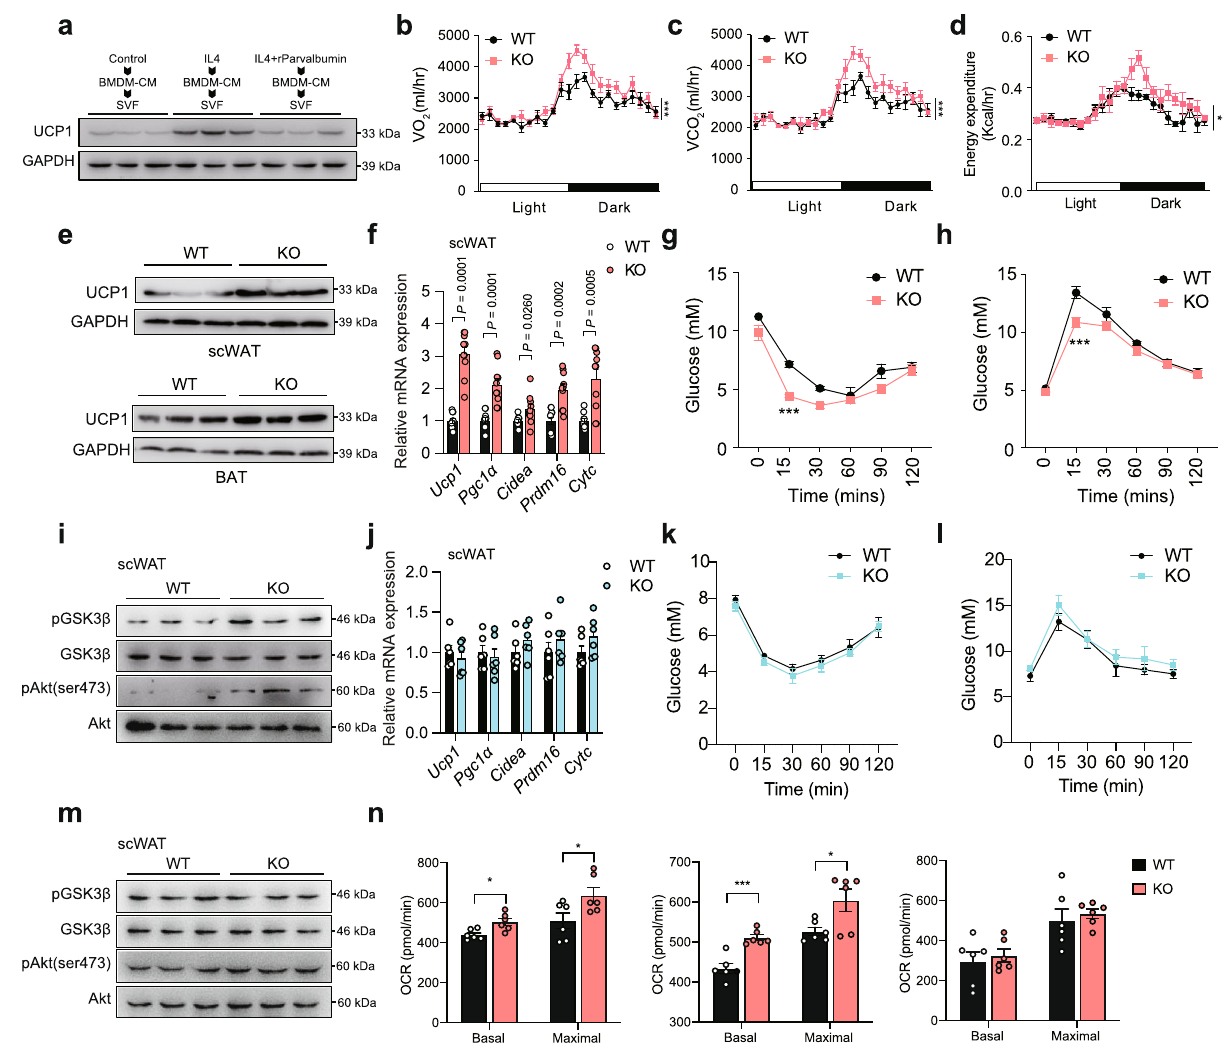
Fig. 5 Effects of parvalbumin KO on thermogenesis, insulin sensitivity, and glucose homeostasis. a Immunoblots of UCP1 in primary adipocytes after exposure to CM for 24 h ( n = 3; representative of 3 biological replicates per group). Oxygen consumption (VO 2 ) ( b ), carbon dioxide production (VCO 2 ) ( c ), and energy expenditure ( d ) of WT and male parvalbumin KO mice ( n = 6 per group). e UCP1 protein expression in scWAT and BAT of WT and parvalbumin-KO mice under room temperature. f Representative thermogenic gene expression in scWAT of WT and parvalbumin KO mice ( n = 10 per group) under room temperature. Insulin tolerance ( g ) and glucose tolerance ( h ) test of WT and parvalbumin KO mice under room temperature ( n = 8 per group). i Representative immunoblots showing effects of parvalbumin KO on insulin signaling in scWAT under room temperature. j Representative thermogenic gene expression in scWAT of male WT and parvalbumin KO mice ( n = 6 per group) under thermoneutrality condition. Insulin tolerance ( k ) and glucose tolerance ( l ) test of male WT and parvalbumin KO mice under thermoneutrality condition ( n = 6 per group). m Representative